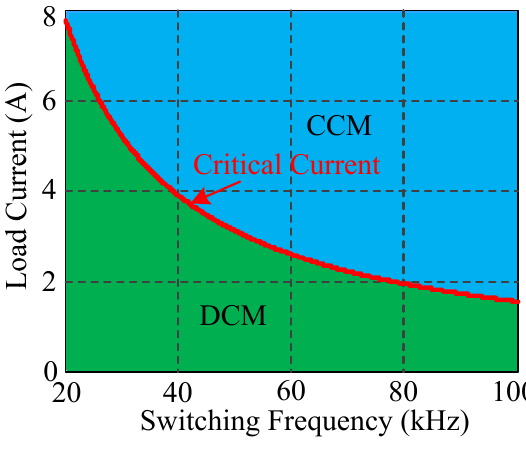
Figure 7. Switching frequency effect on the critical